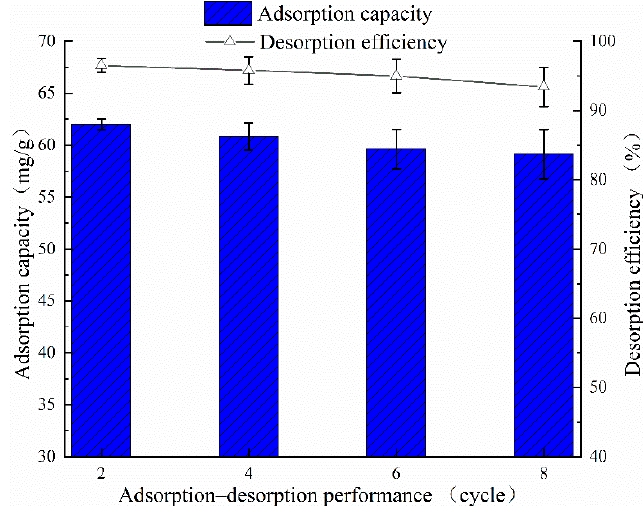
Figure 4. Reusability of resin D201 for caproate production. The adsorption and desorption of caproate versus resin were measured over eight performance cycles using the simulation broth. The results are averages and standard deviations of three parallel experiments.